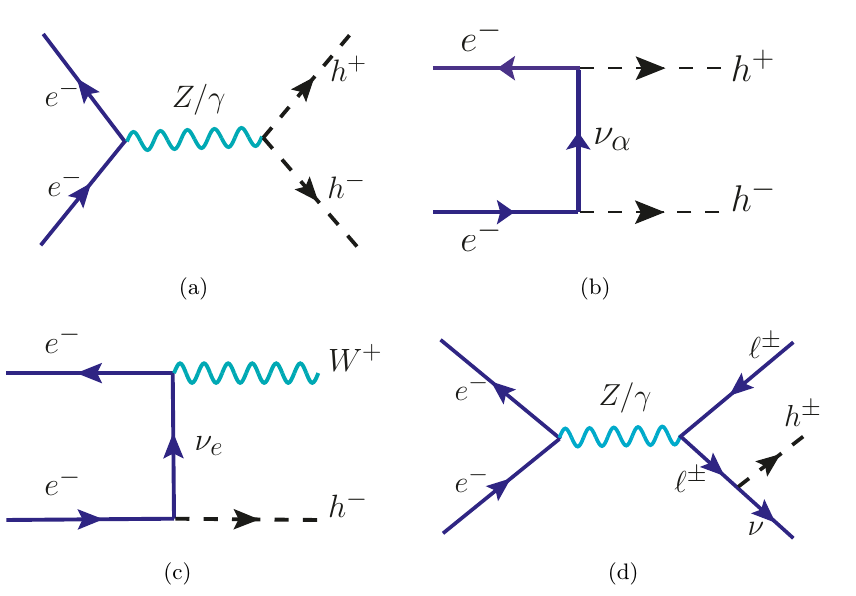
Figure 10 . Feynman diagrams for pair- and single-production of singly-charged scalars h (cid:6) at e + e (cid:0)